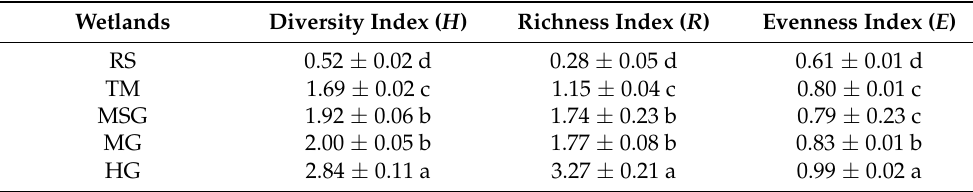
Table 2. Diversity index of wetland plant community under different land